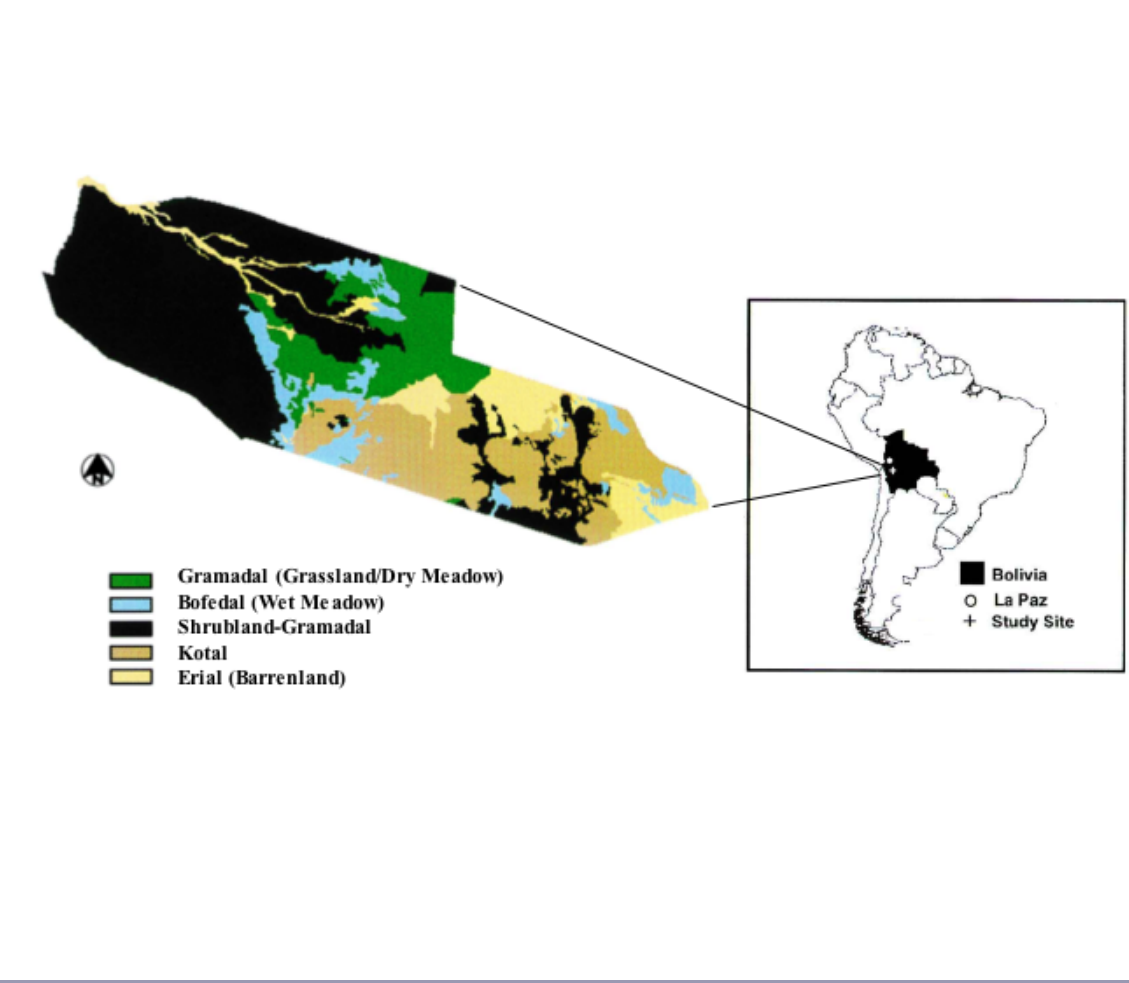
Fig. 1. The study site, San Jose Llanga, is located in the northern Altiplano of Bolivia, 120 km south of the capital city of La Paz. The vegetation cover map is adapted from Norton (1992) and Washington- Allen et al.